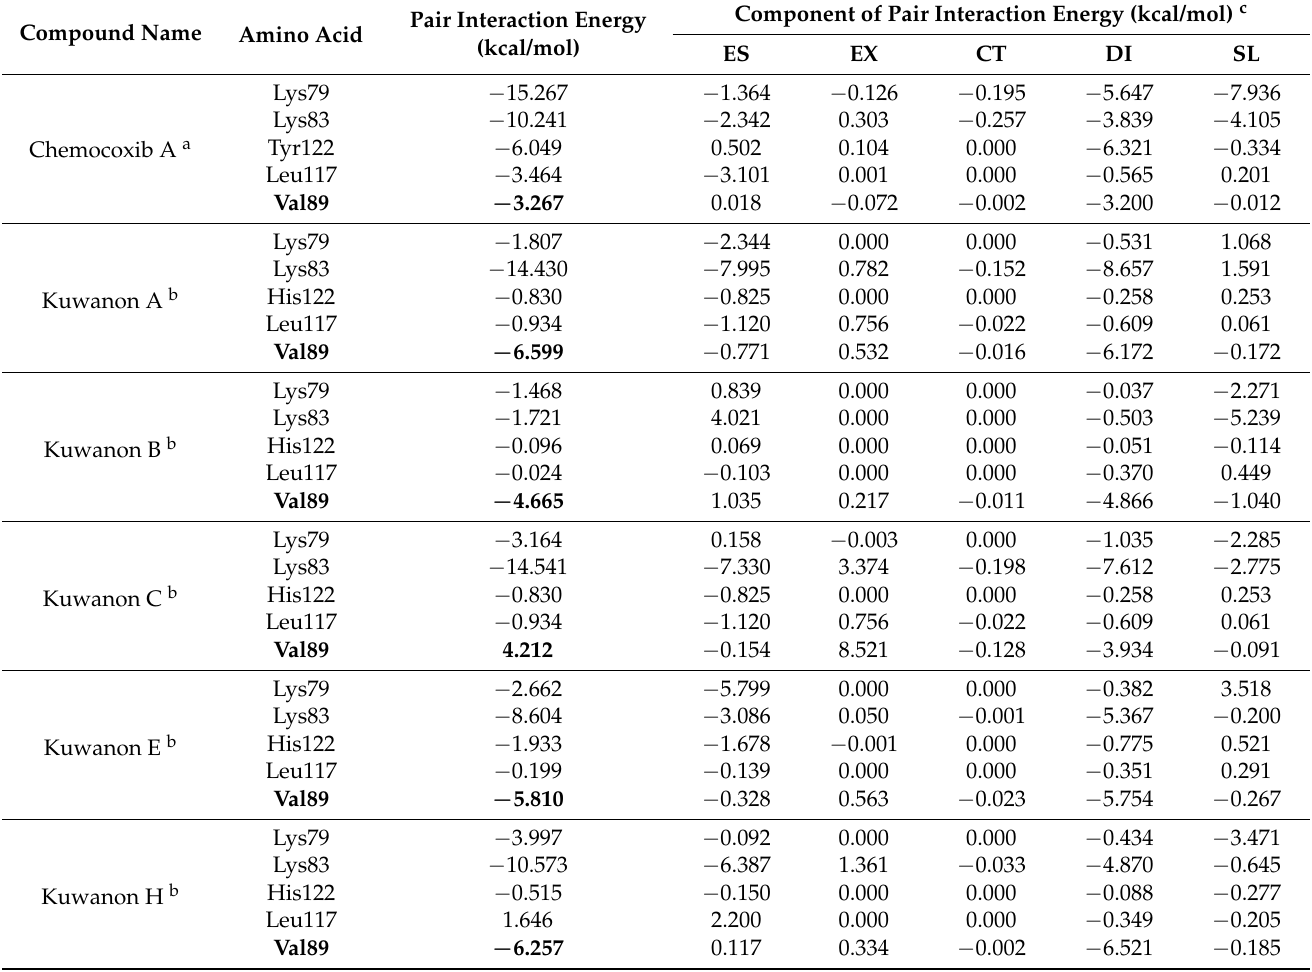
Table 3. PIEDA of the five amino acids in the membrane-binding domain of